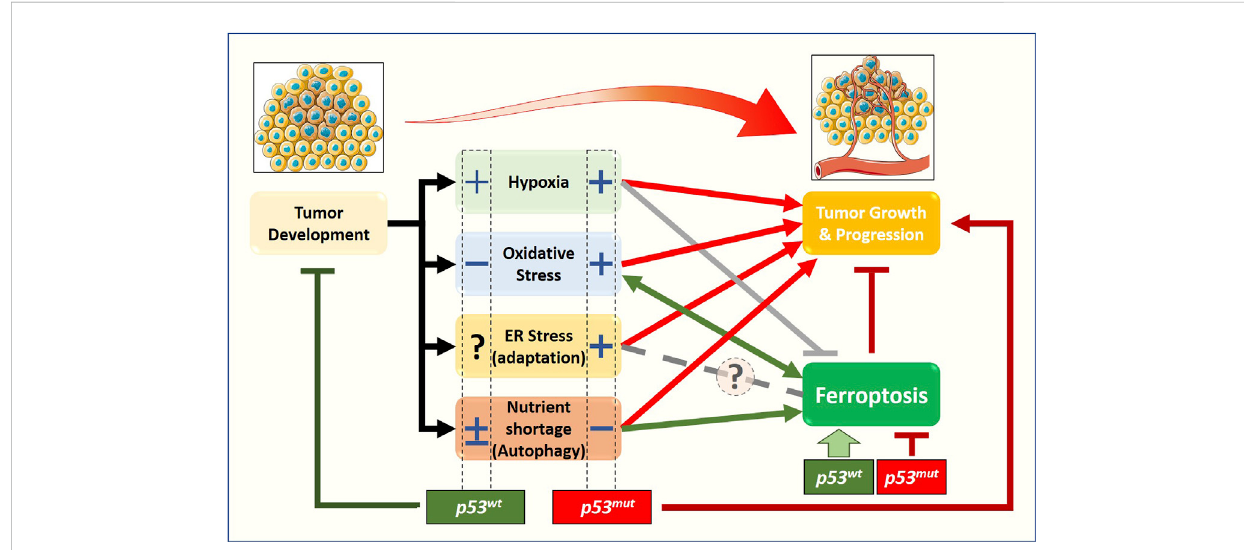
FIGURE 2 Relationship between stress-related signaling pathways, ferroptosis, and tumor growth, from a p53 status-centered (wt or mut) perspective. In the earlystagesofsolidtumordevelopment,cancercellsaresubjectedtooxygenandnutrientshortage,oxidativestress,anddysfunctionalproteostasis.The molecular pathways activated in response to those stimuli will de fi ne the fate of the early tumor: survival (red arrows) or death. Beyond apoptosis, very recently, the new form of cell death named ferroptosis has been described to have a role in preventing/limiting the early tumor formation and growth, although the precise molecular mechanisms are still elusive. Emerging data show that stress-related signaling pathways have a non-negligible impactonferroptosisinduction/execution,withsomeofthemstimulating(greenarrows)whileotherpreventingorinhibiting(graylines)theprocess,thus enhancingorweakeningtheimpactofferroptoticcelldeathontumorgrowthandprogression.Thecomplexityofthisscenarioisfurtherampli fi edbythe cellular response to stress-induced activation of the p53 tumor suppressor, and by the fact that a large fraction of tumors express gain-of-function p53 mutants. Accumulating data suggest that the p53 status (wt vs. mut) might have a signi fi cant impact on ferroptosis and tumor growth through a positive (+) or negative ( − ) effect on cancer-associated stress-related signaling